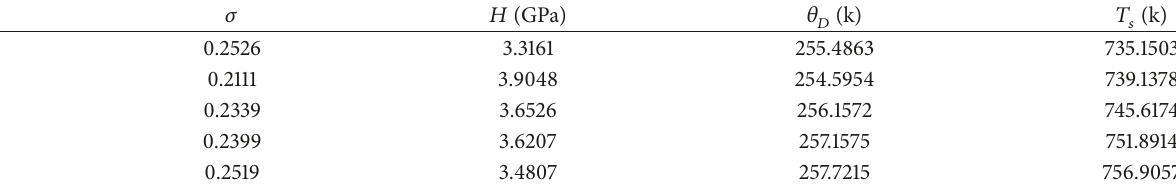
Table 4: Poisson’s ratio, microhardness, Debye temperature, and softening temperature of [( TeO 2 ) 0.70 ( ZnO ) 0.30 ] (1−𝑥) ( Nd 2 O 3 NPs ) (𝑥) glasses.